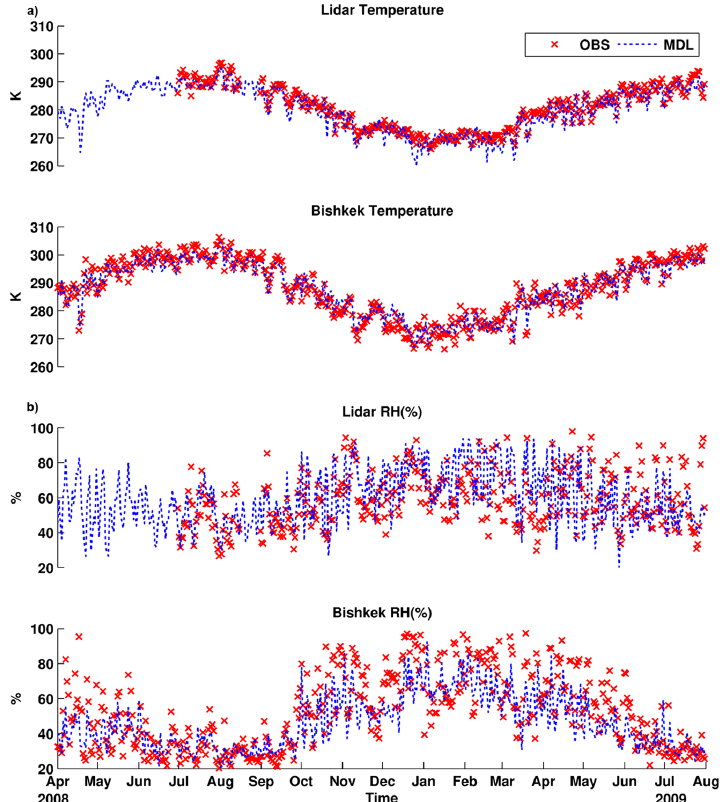
Figure 10. Temporal variability in simulated (a) temperature (K) and (b) relative humidity (RH, %) from the WRF model compared with observations at the LST and Bishkek sites. “Lidar” denotes the LST